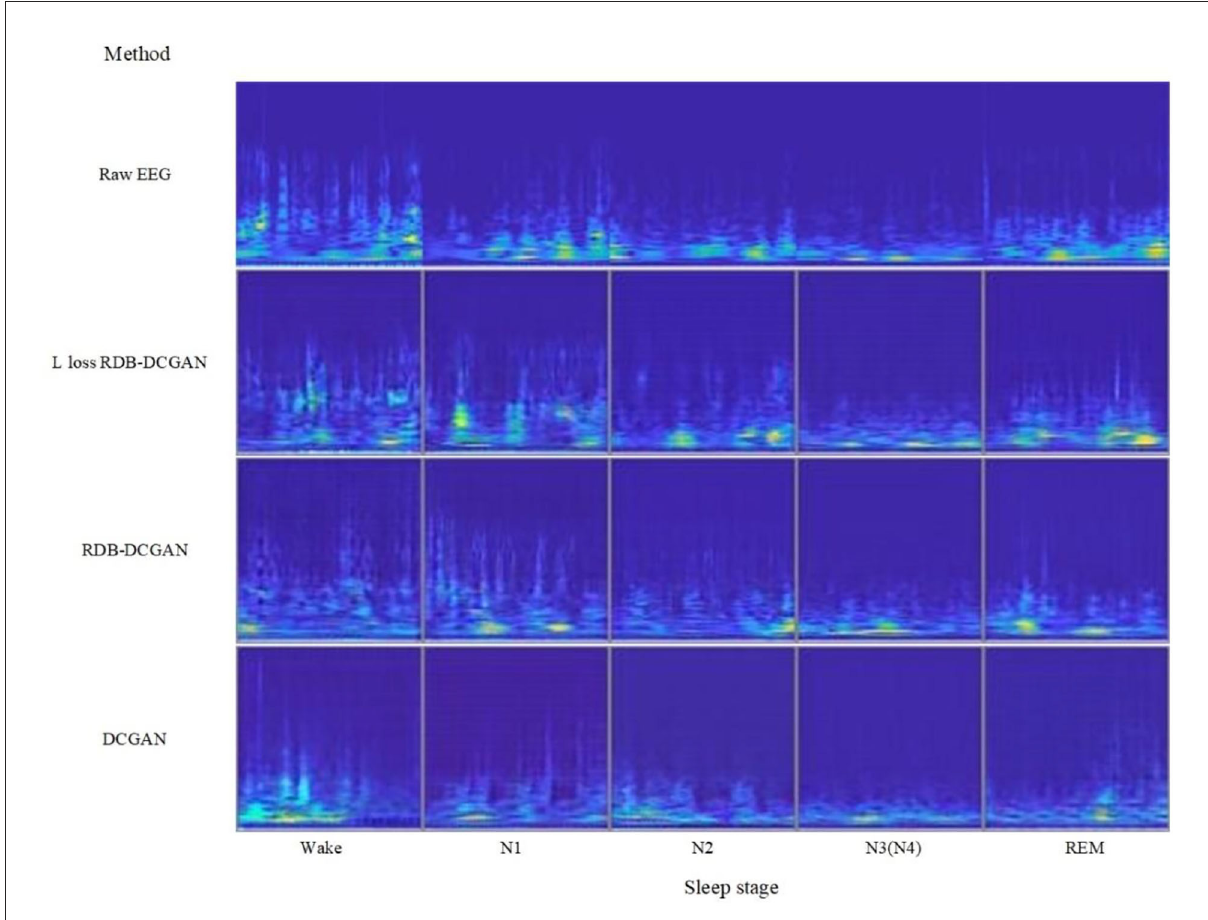
FIGURE8 Comparison of the original image and generated image.